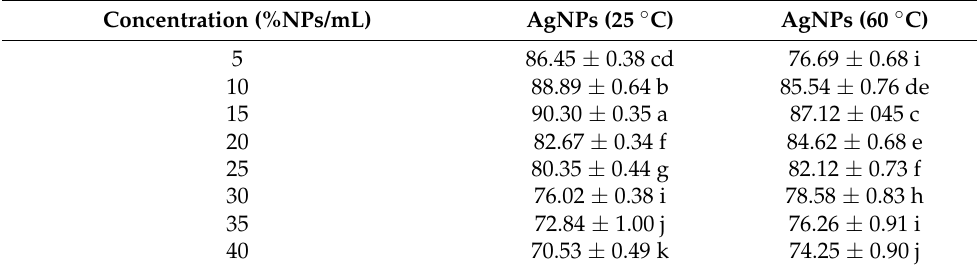
Table 1. Antioxidant activity.